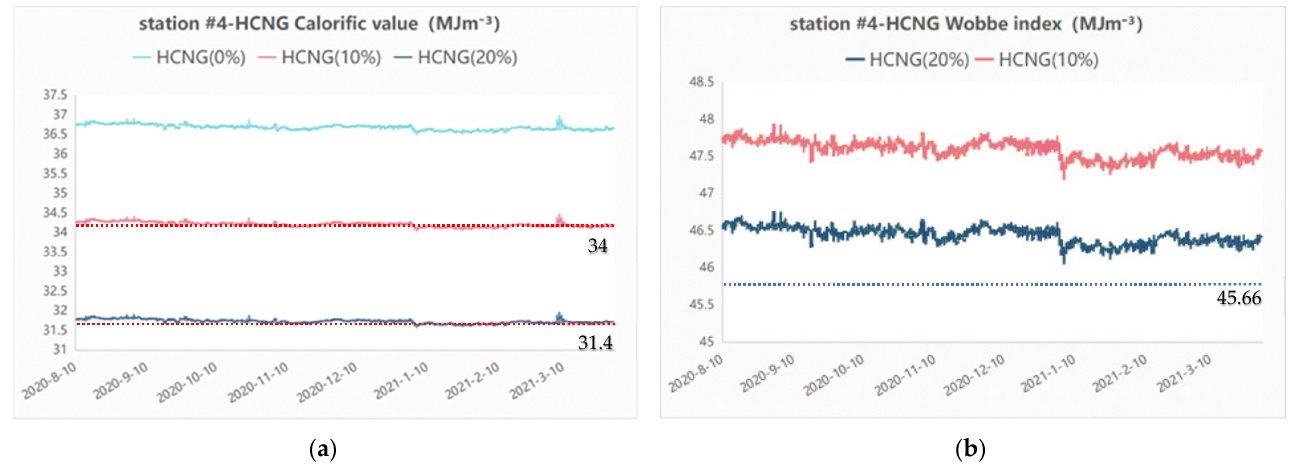
Figure 6. ( a ) Calorific value of natural gas source station #4 measured between August 2020 and March 2021. ( b ) Wobbe Index of natural gas source station #4 measured between August 2020 and March 2021. The light blue line in Figure 7a is the real calorific value of gas source station #5. The